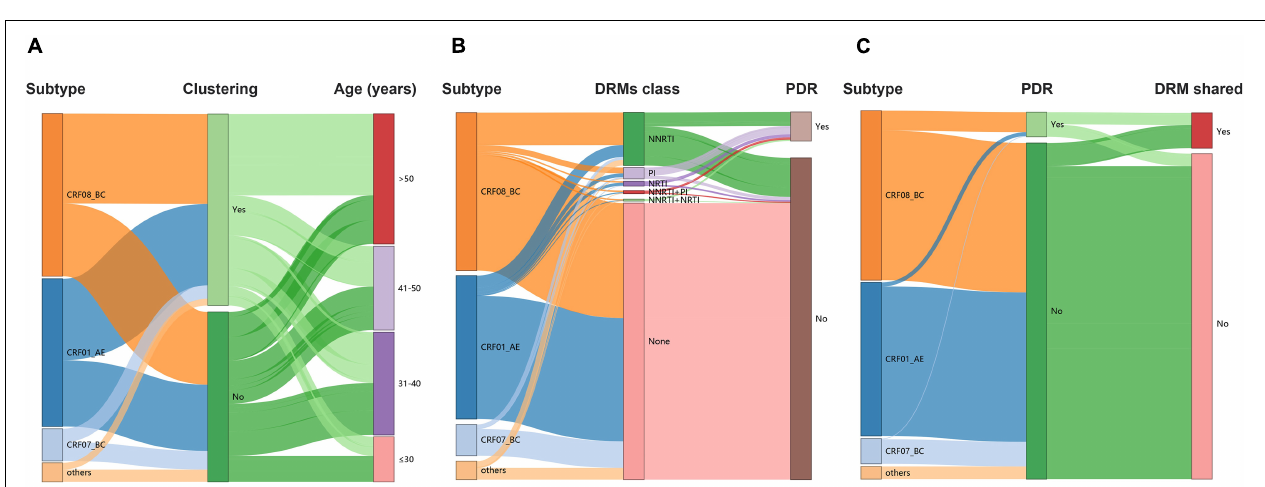
identified as members of 36 different clusters ( Figure 4D ). ( Supplementary Table 1 ). Among clustering individuals with DRMs, 53/100 (53.0%) were genetically linked partners in 15 DRM sharing clusters, suggesting DRM transmission among ART-naïve patients ( Figure 2B ). The most prevalent